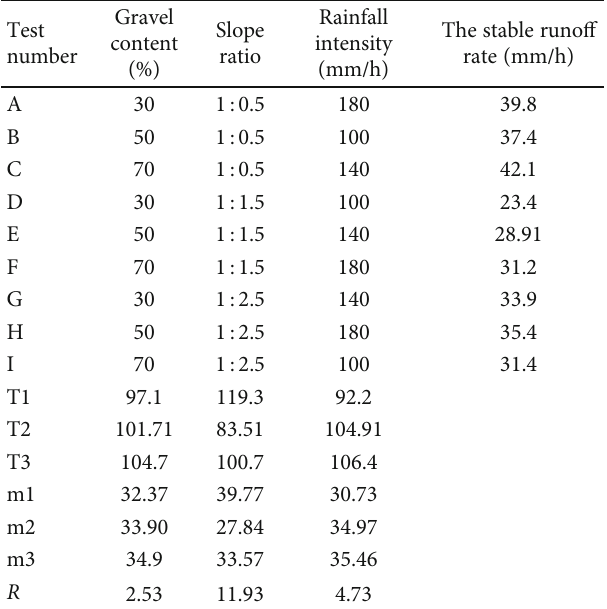
Figure 10: Relationship between the average steady runo ff rate and gravel content, slope ratio, and rainfall intensity. Table 3: Analysis of the in fl uencing factors of the in fi ltration rate in stable